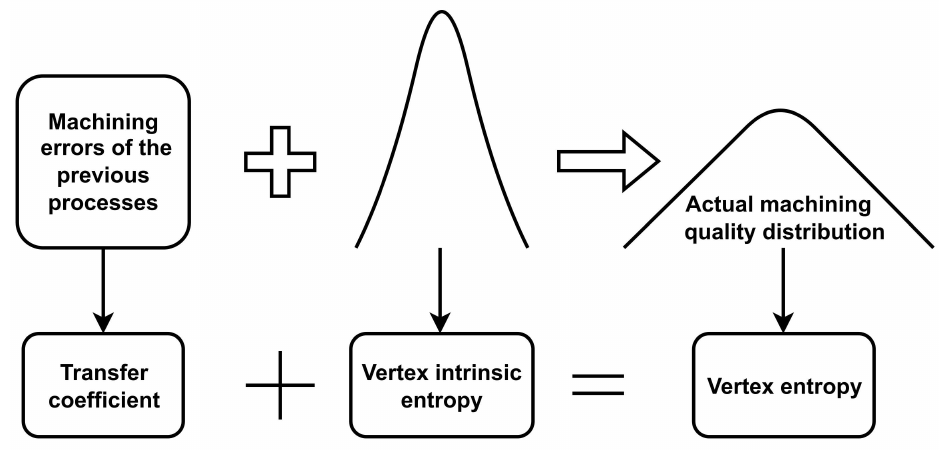
Figure 5. The composition of the vertex